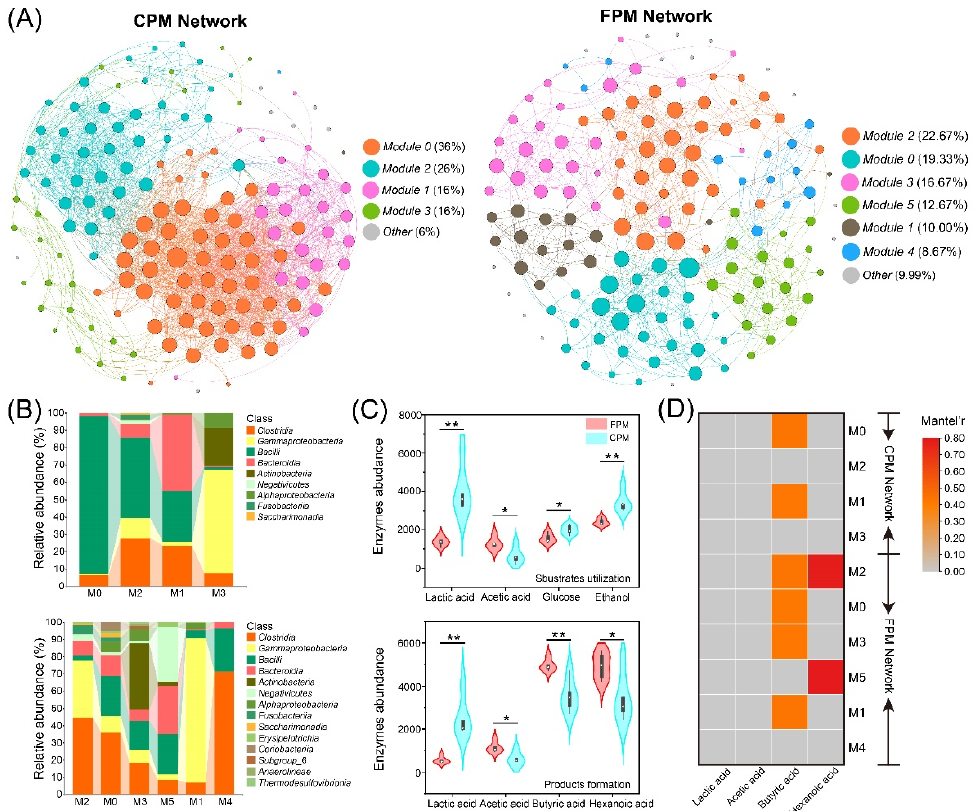
Figure 6. Bacterial co-occurrence networks and the community composition and potential function of primary modules. ( A ) The co-occurrence network analysis of bacterial community ASVs: each dot represents a bacterial ASV, and the links represent statistical significance (| ρ | > 0.7, p < 0.05). ( B ) The community composition of primary modules at the class level. ( C ) The abundance variation of functional genes encoding for key enzymes involved in substrate utilization and product formation in bacterial communities of FPM and CPM. Significant values based on t -test are shown as: * p < 0.05; ** p < 0.01. ( D ) Mantel test between primary modules and important organic acids; correlations with p > 0.01 are marked in grey.